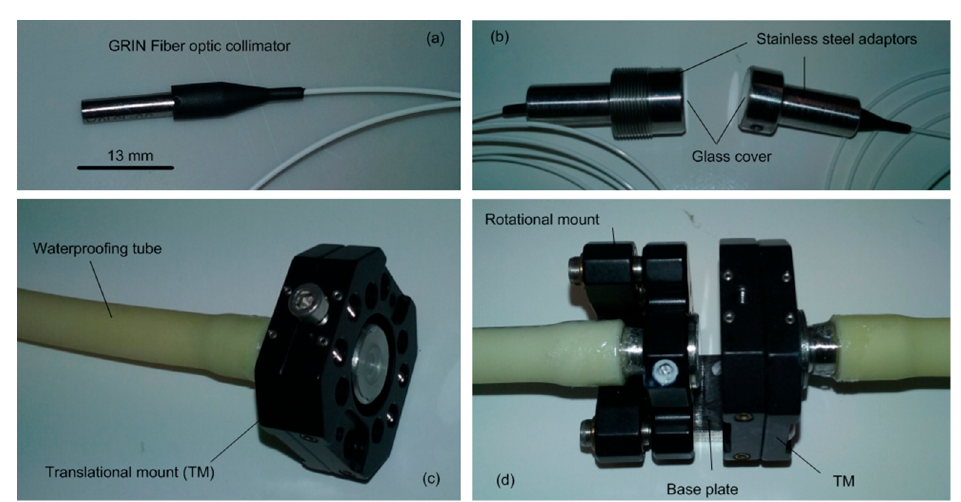
Figure 8. Components of the immersible sensor for the in situ measurement of PEG concentrations. ( a ) Optic fibre connected to a GRIN collimator; ( b ) Emitting and receiving GRIN collimators placed in stainless steel adaptors with glass cover for water tightness.; ( c ) Stainless steel adaptor connected to a translational mount used to adjust the relative positions of the GRIN collimators and ensure that the laser enters the receiving GRIN collimator. A waterproof tube is used for water tightness; ( d ) Both GRIN collimators, installed in the translational and rotational mounts. Both mounts are fixed to a base plate maintaining the position of the mounts and the gap between the two GRIN coolimators.